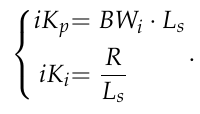
Table 1. The parameters of the motor.